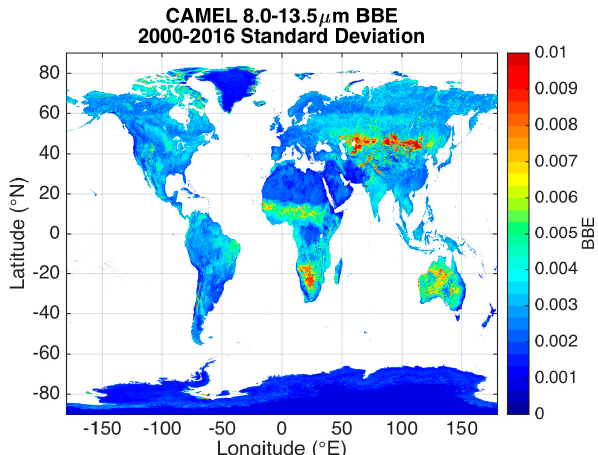
Figure 6. Monthly climatology of CAMEL 8.0–13.5 µm BBE over 2000–2016 for the month of ( a ) January; ( b ) April; ( c ) July and; ( d ) October.